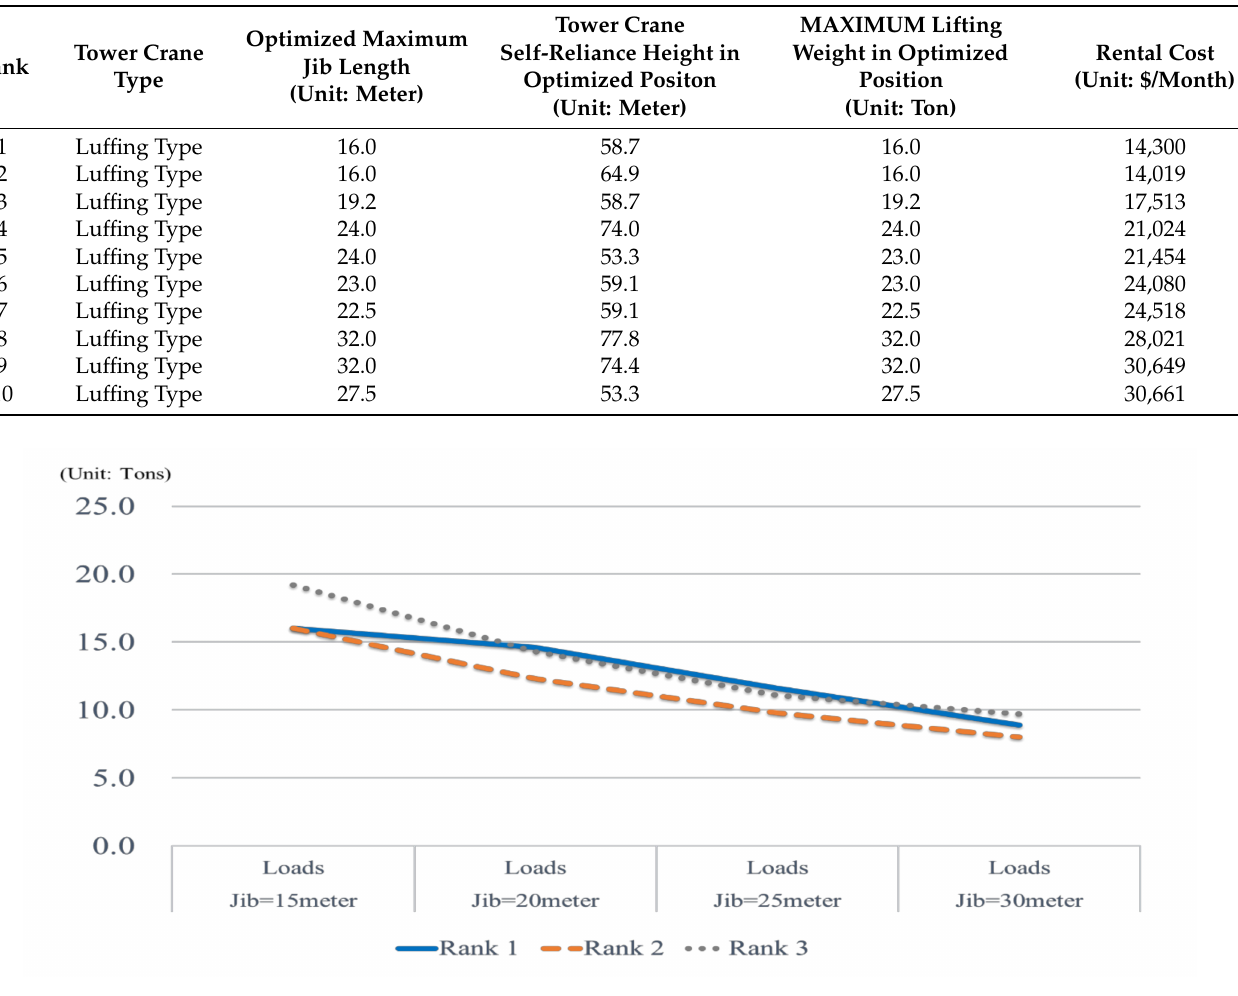
Figure 7. The relationship between the change in jib length and maximum lifting loads following from rank 1 to 3 tower crane’s